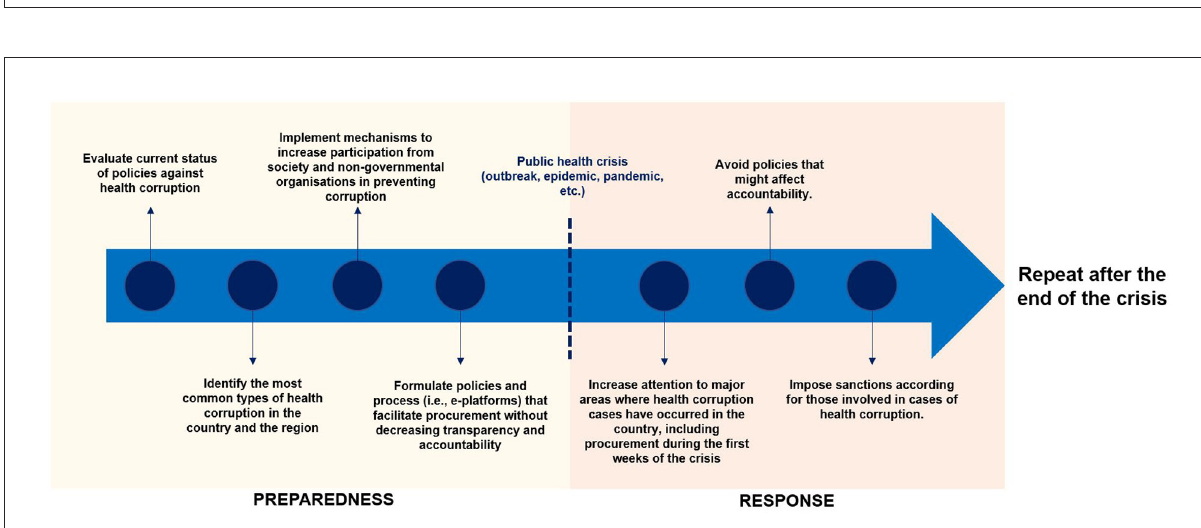
FIGURE2 Preparedness and response for health corruption during a public health